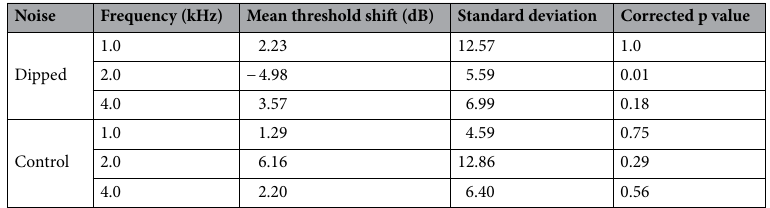
Table 1. Results of Bonferroni corrected single sided t-tests of mean threshold shifts against zero.